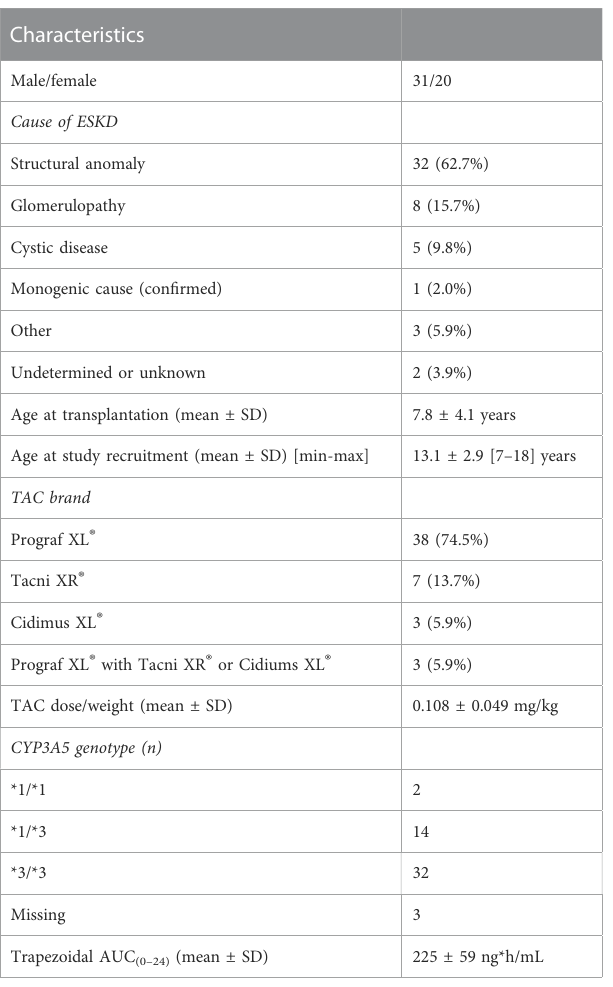
TABLE1Basicdemographic,clinicalandgeneticinformationofChileankidney recipients.